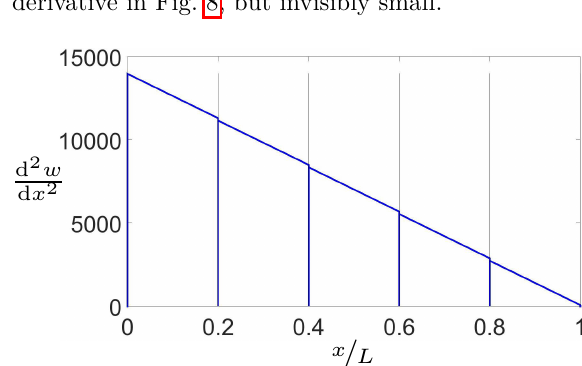
Table: Dimensions, loads and material parameters